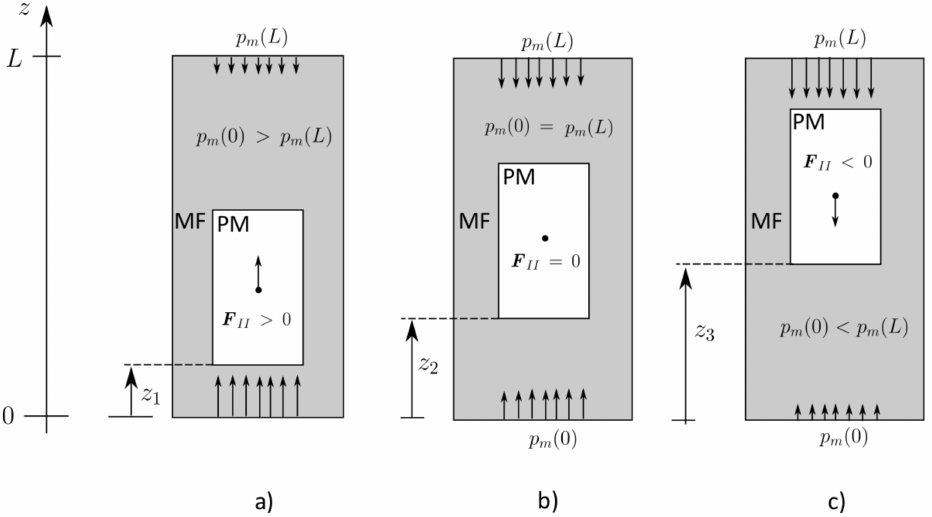
Figure 3. Visual representation of how magnetic fluid pressure contributes to the self-levitation mechanism: ( a ) In this position, a magnetic field is much higher at the bottom of the container than it is at the top of it, thus, the magnetic fluid pressure is also higher at the bottom, which results in PM upward movement; ( b ) In the stable levitation position, or in equilibrium height, the magnetic fluid pressure is balanced within the container; ( c ) If the PM tends to move up somehow, the pressure on the top increases due to the higher magnetic field, and the PM starts to move toward the stable